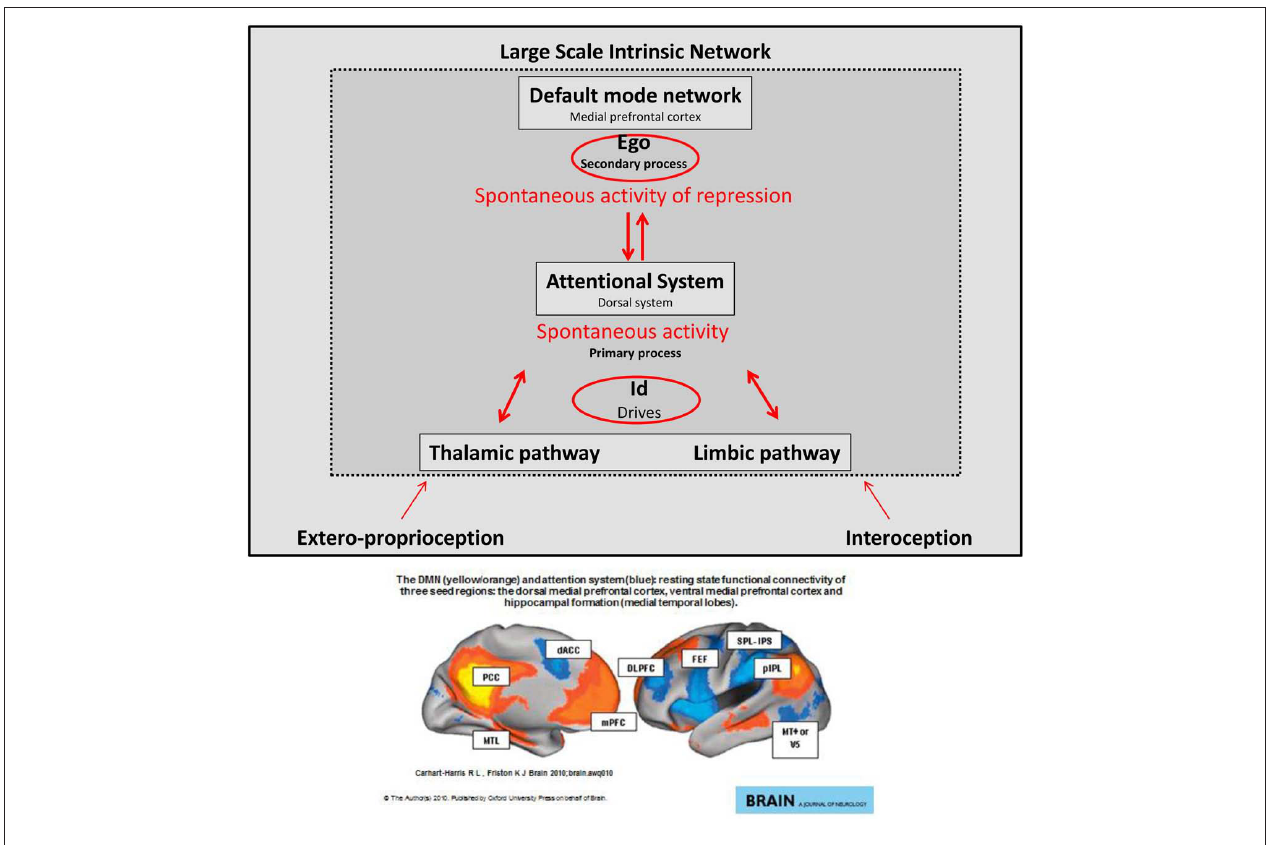
Figure 2 | (Above) Convergences between Freud’s second topic and brain’s Large Intrinsic Network, after Carhart-Harris and Friston (2010). (Below) The default network (yellow/orange): the dorsal medial prefrontal cortex, ventral medial prefrontal cortex, and hippocampal formation, when activated are